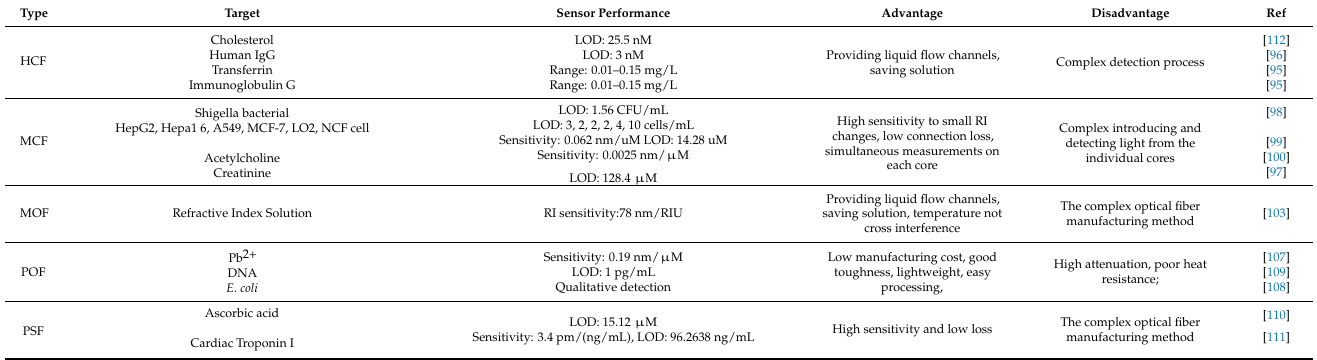
Table 3. The recognition method of the target detection substance of different specialty fiber optic sensor.